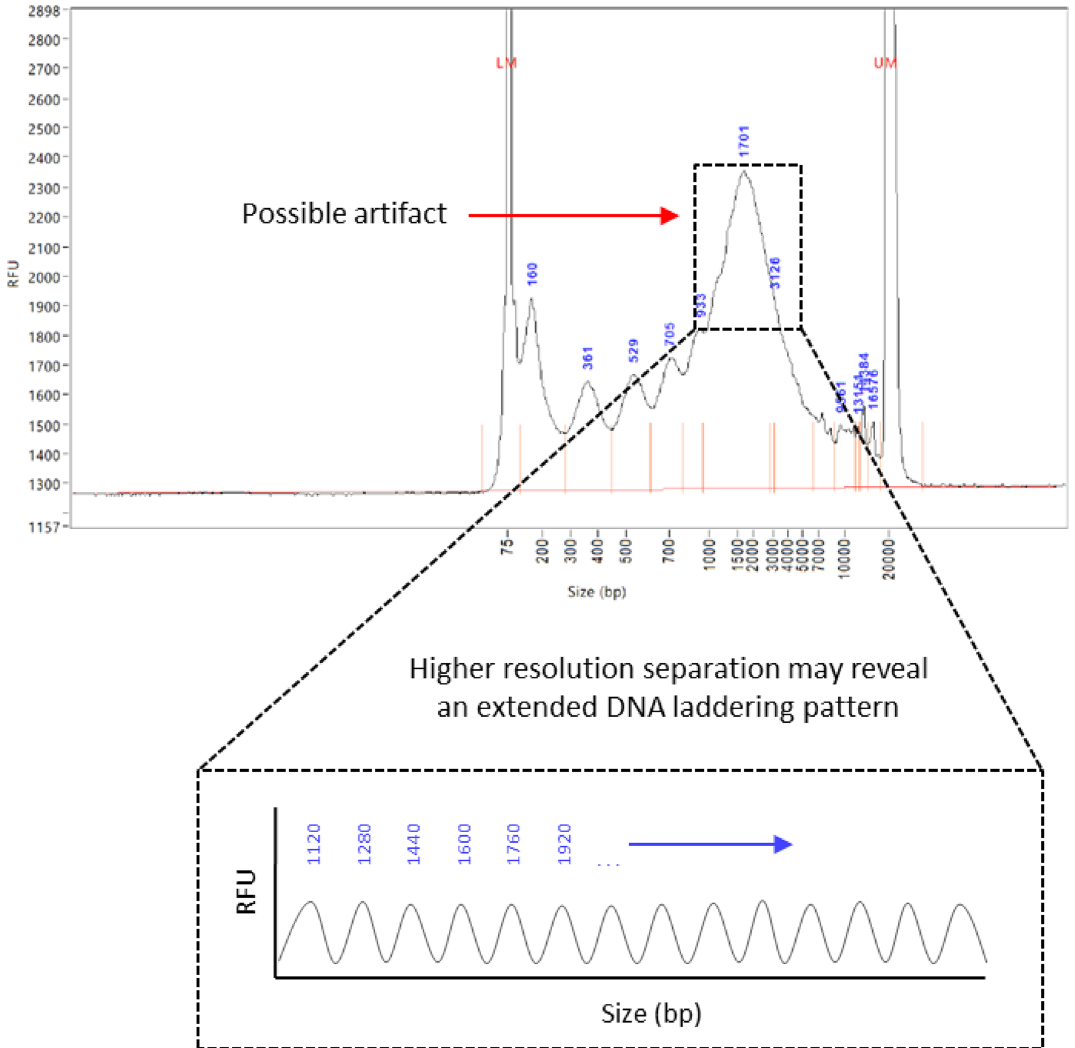
Figure 6. A cell-free DNA (cfDNA) peak that ranges between 1–6 kbp may be an artifact of incomplete size separation. Due to the resolution limitations of electrophoretic methods, several individual cfDNA populations are grouped into a single peak. Deconvolution of this peak through complete size separation may reveal an underlying DNA fragmentation profile that continues the series of DNA